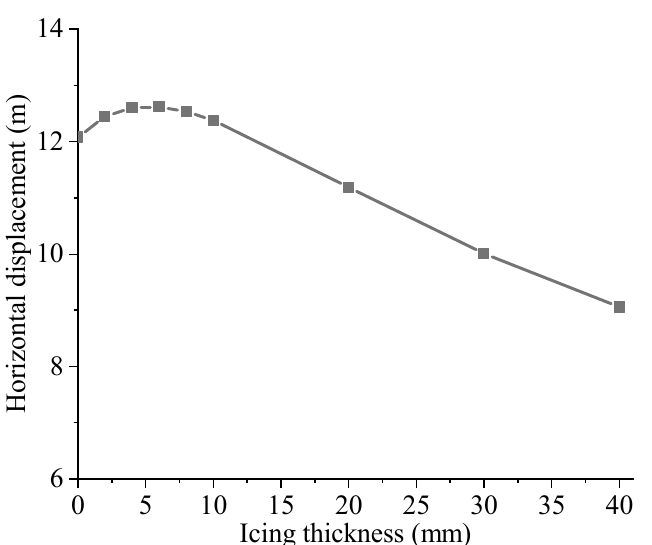
Figure 16. The influence of wind speed on maximum horizontal displacement of conductor.